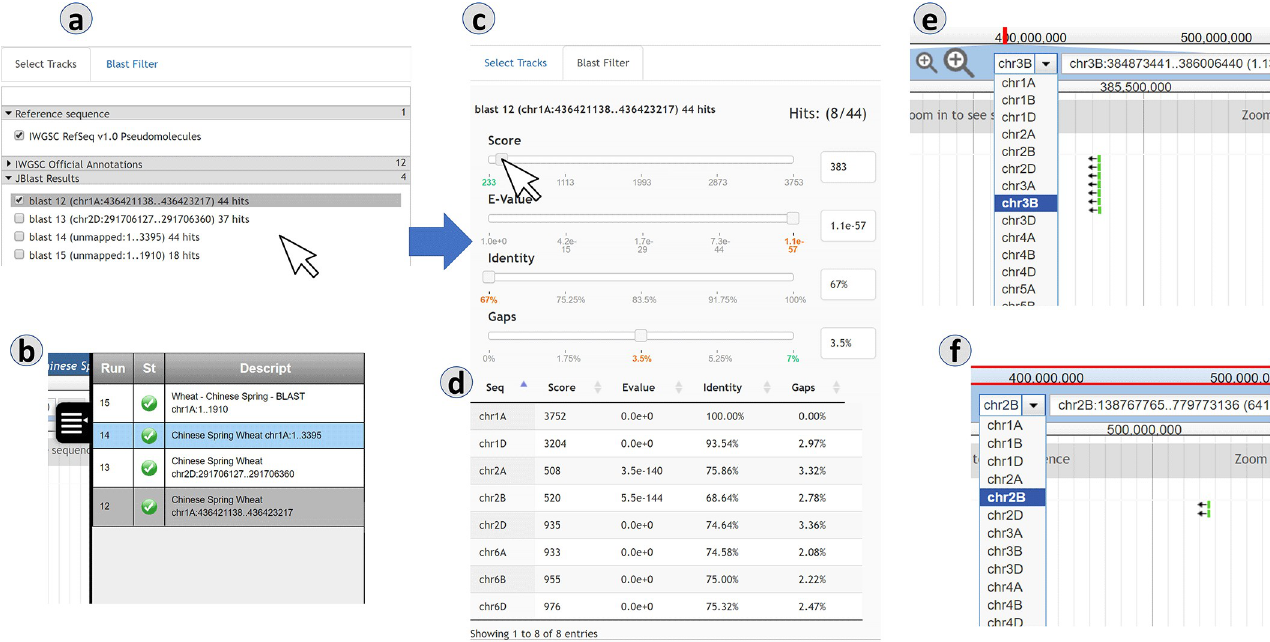
Fig 4. In the reference-as-target mode, matches to the user-uploaded sequence may be located all over the genome. As with the reference-as-query mode, the BLAST hits can be dynamically filtered through the control panel. Panels: (a) BLAST result tracks, (b) completed jobs in queue, (c) BLAST filter, (d) BLAST results table, (e/f) BLAST result